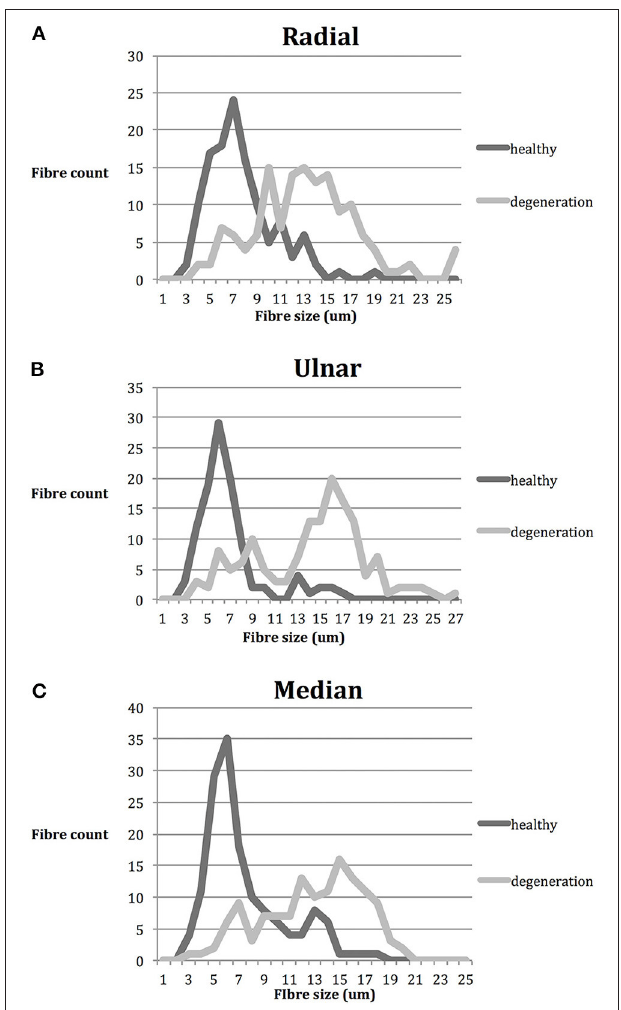
FIGURE 5 | Nerve fiber distribution according to size ( µ m). n = 796. Gray: healthy; black: degenerative. (A) Radial nerve; smaller fibers were largely spared from degeneration, whilst the larger fibers are affected (B) Ulnar nerve; similar distribution to radial nerve, with two clear peaks of healthy and degenerative fibers (C) Median nerve; similar distribution to both radial and median nerve. The peak of healthy fibers count corresponds mainly to A δ and A β fibers whilst the degeneration peak corresponds to A α fibers.